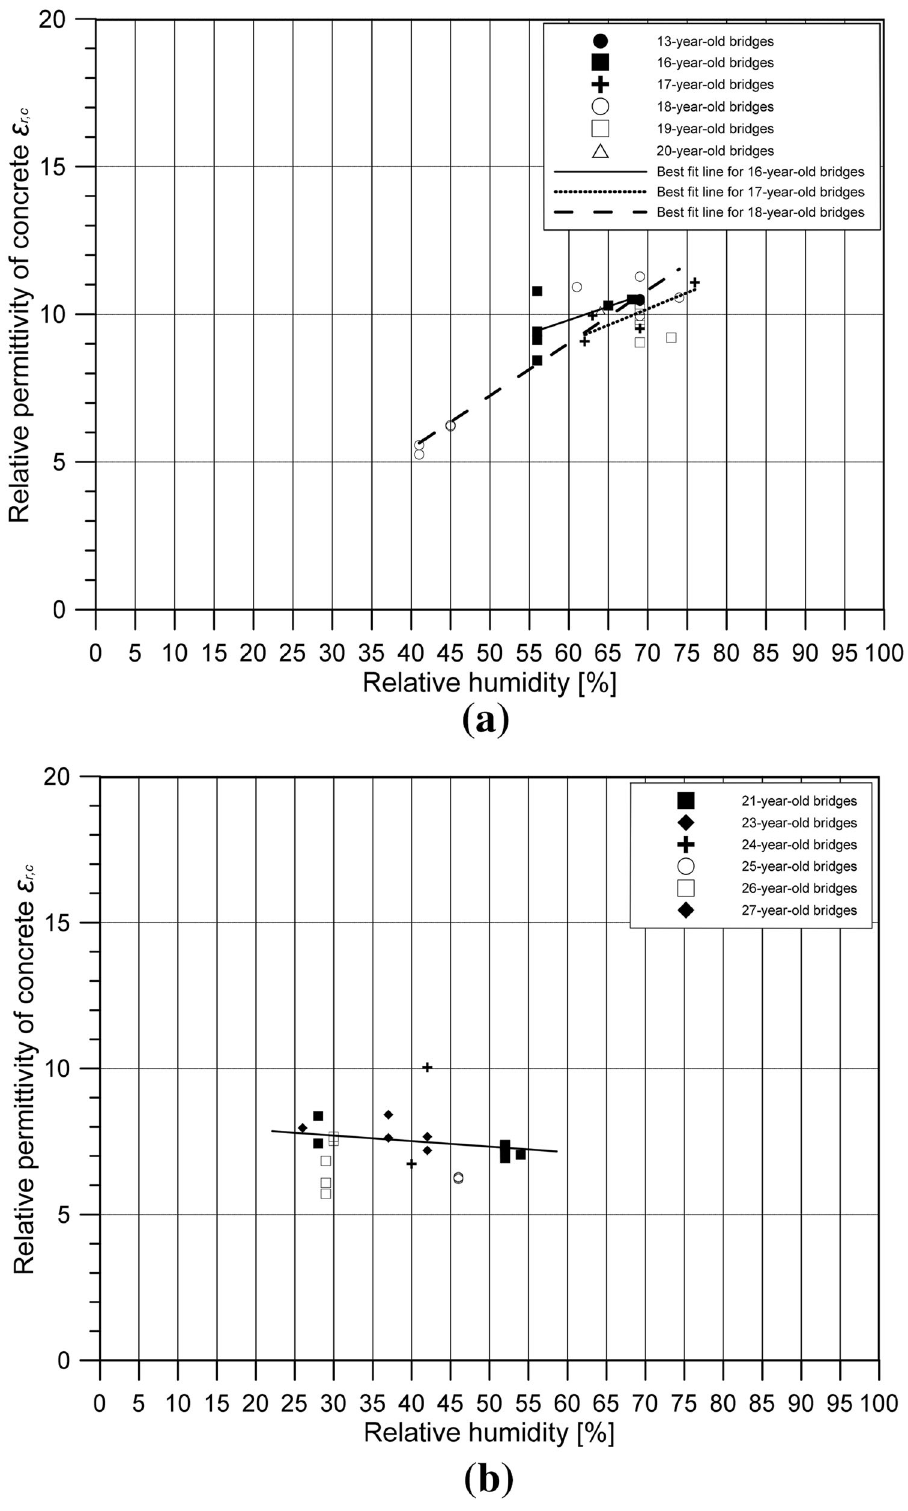
Fig. 8 Variation of relative permittivity of concrete with relative humidity of air: a group 1: concrete age lower than 20 years at the moment of GPR measurements and b group 2: concrete age greater than 20